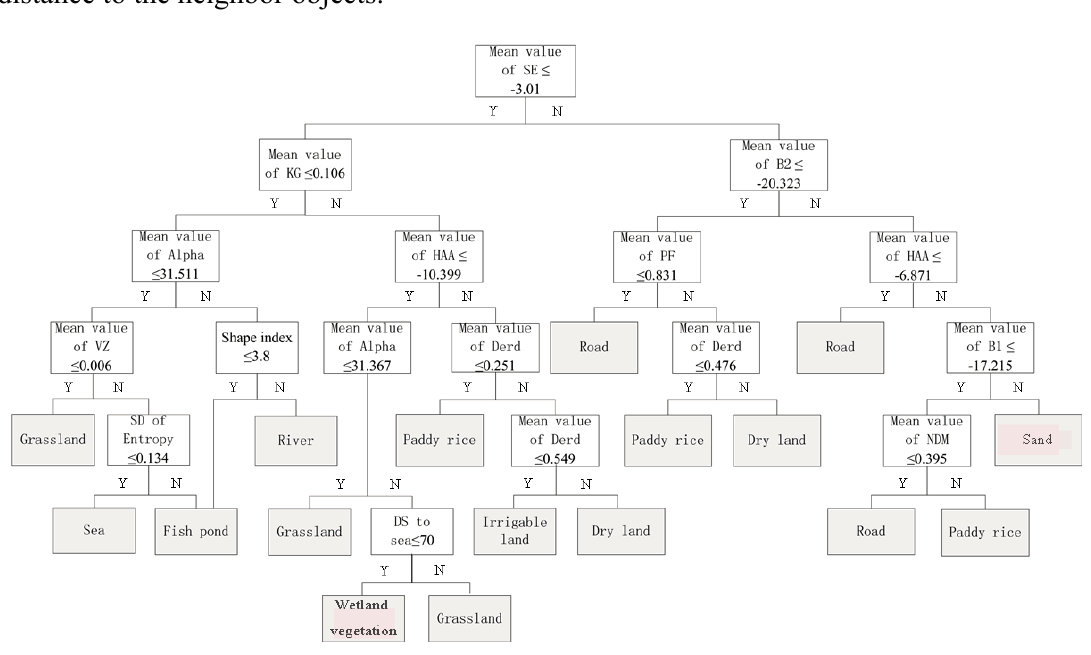
Figure 5. Structure of the decision tree. SE, Shannon entropy; KG, Krogager_Kd; B2, Barnes2_T33; HAA, HAAlpha_T11; PF, Polarization Fraction; VZ, VanZyl3_Vol; B1, Barnes1_T33; NDM, Neuman_delta_mod; SD, the standard deviation of entropy; DS, the distance to the neighbor